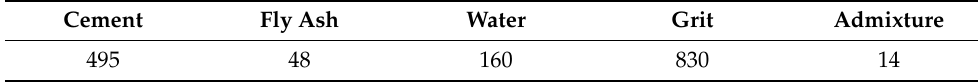
Table 3. The mix of self-compacting concrete (kg/m 3 ).